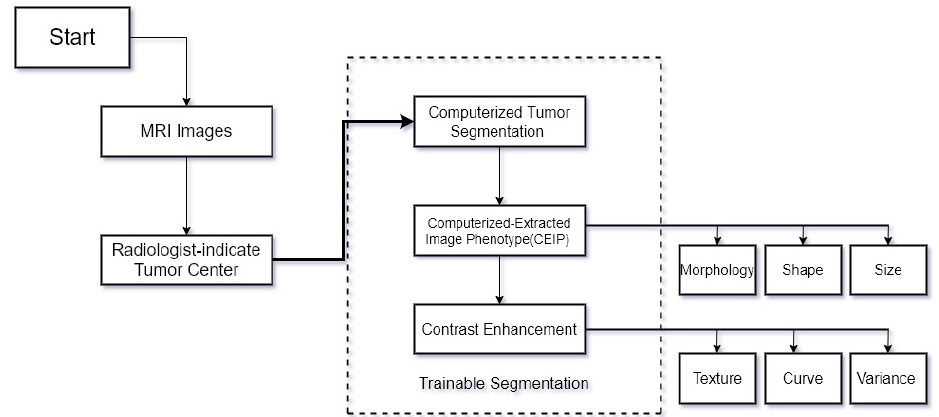
Figure 3. Flow diagram of the CAD